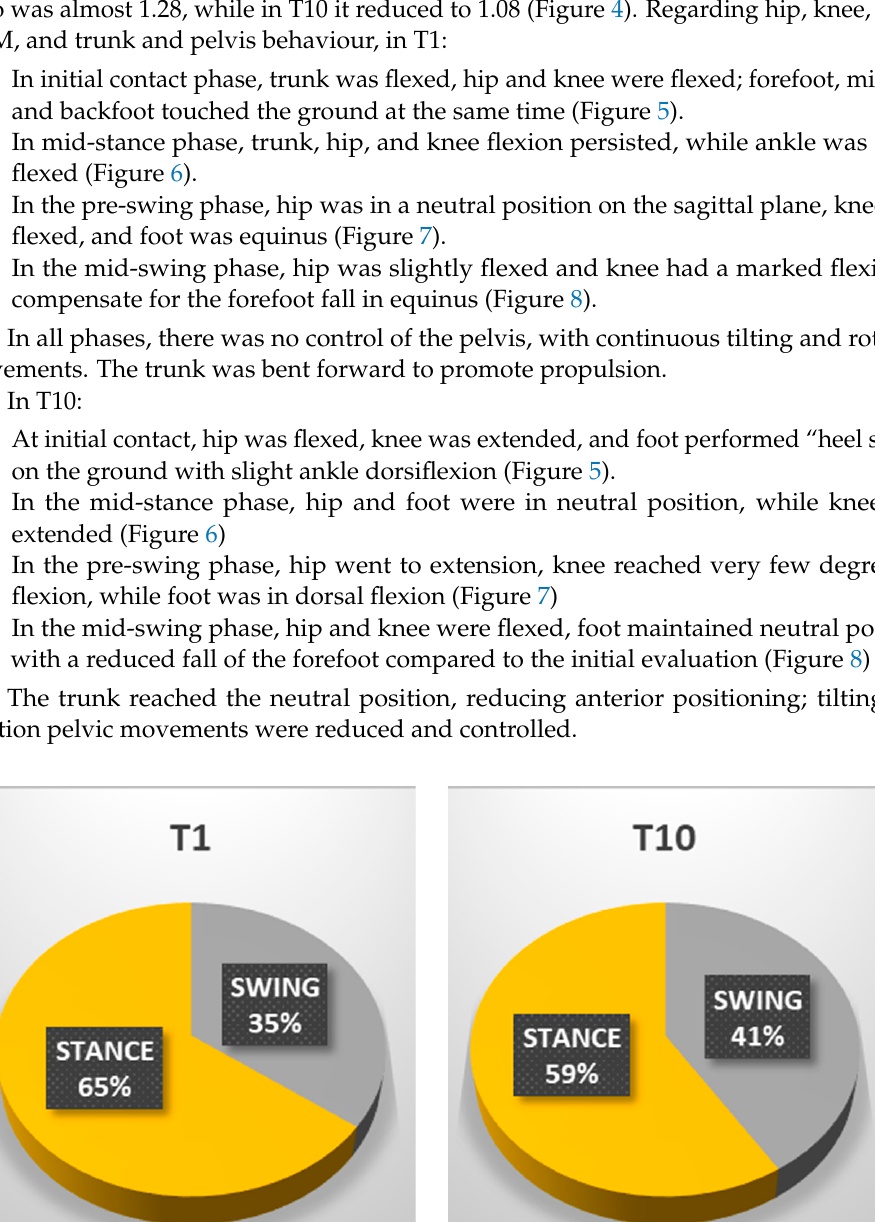
motor control of both lower limbs after a single treatment session. Kinematic gait analysis revealed improvements of time percentages of stance and swing phases. In T1, respective percentages of stance and swing were: stance 65.54%, swing 35.46%. In T10: stance 59.01%, swing 40.99% (Figure 3). Regarding the ratio between left and right step lengths: in T1, this ratio was almost 1.28, while in T10 it reduced to 1.08 (Figure 4). Regarding hip, knee, ankle